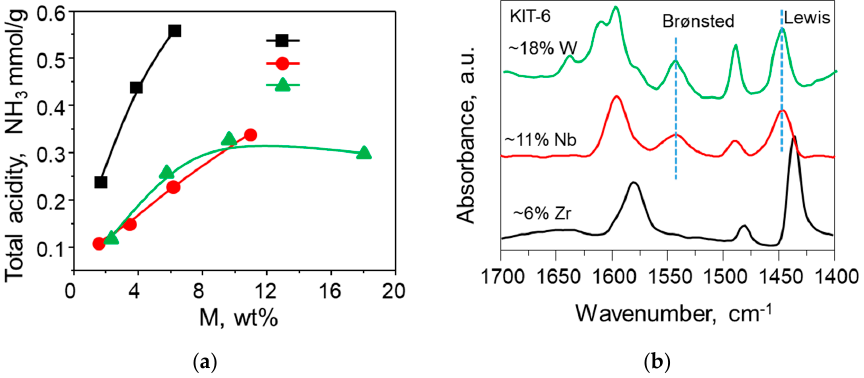
Figure 4. ( a ) Comparison of total acidity variation with metal loading in KIT-6 catalysts; and ( b ) FTIR spectra of adsorbed pyridine over M-KIT-6 at relatively high metal loadings.